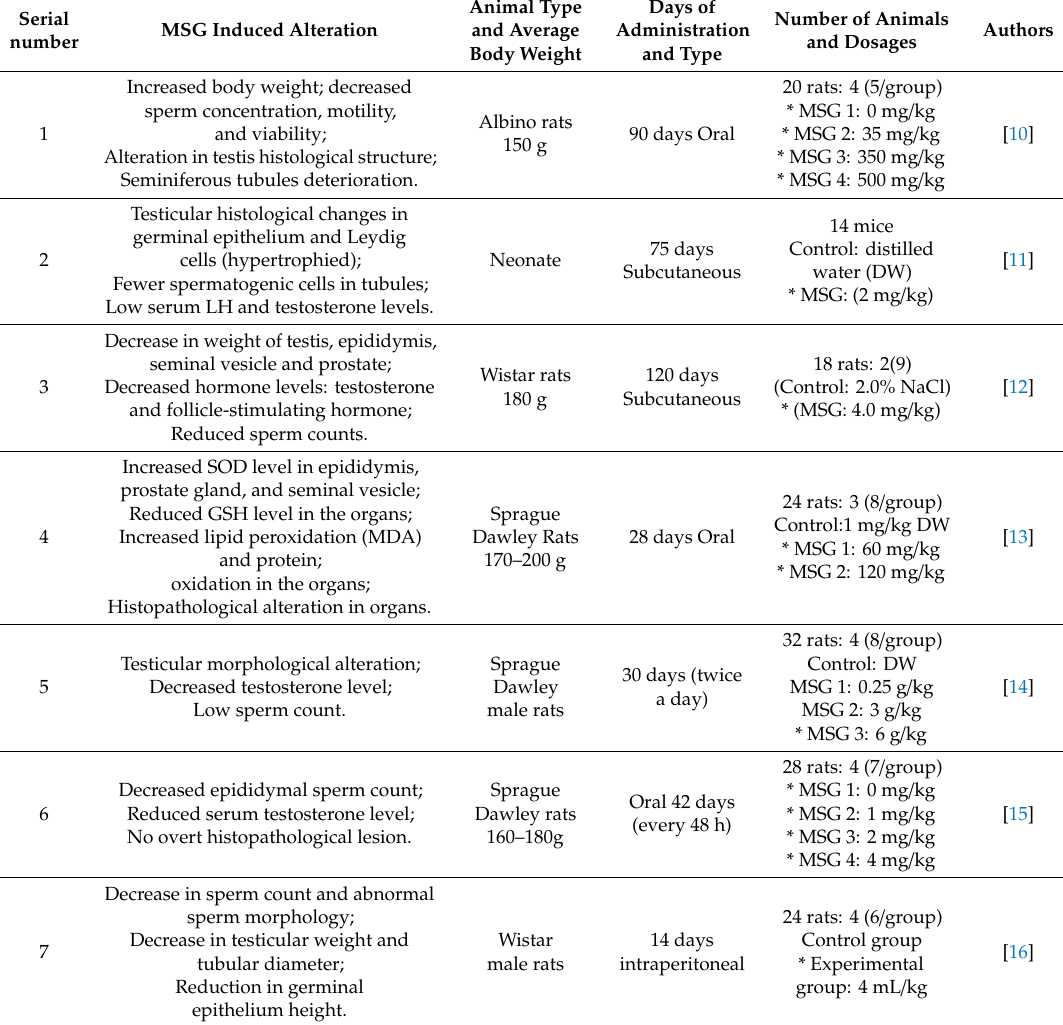
Table 1. Reproductive injury induced by monosodium glutamate (MSG) administration to laboratory animals.